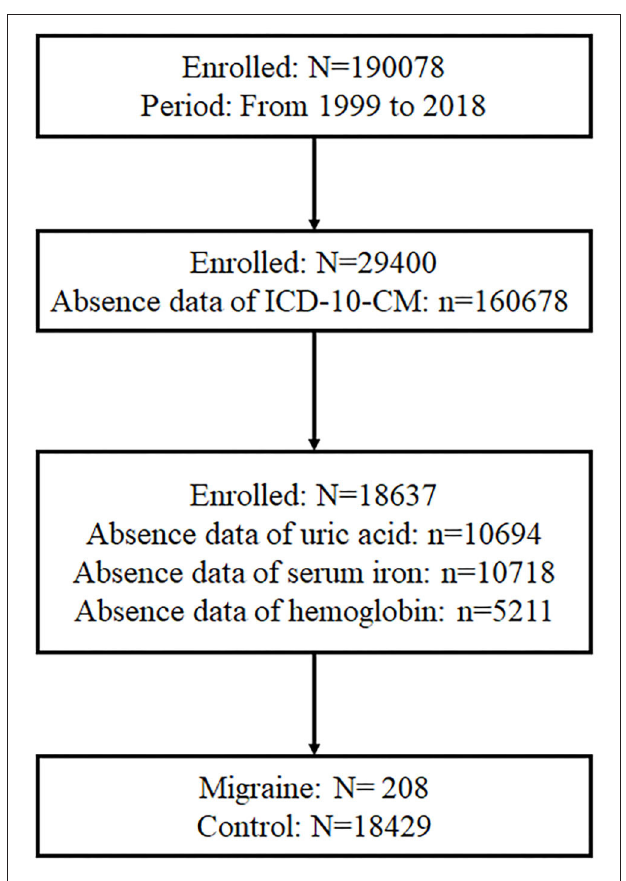
FIGURE 1 | Participants screening procedure. In total, 190,078 participants participated in the NHANES from 1999 to 2018, and 29,400 participants had information about ICD-10-CM. Of the 29,400 participants, 18,637 participants had data of serum urate, serum iron, and hemoglobin. Besides, 208 participants suffered from migraine and had prescription medications for